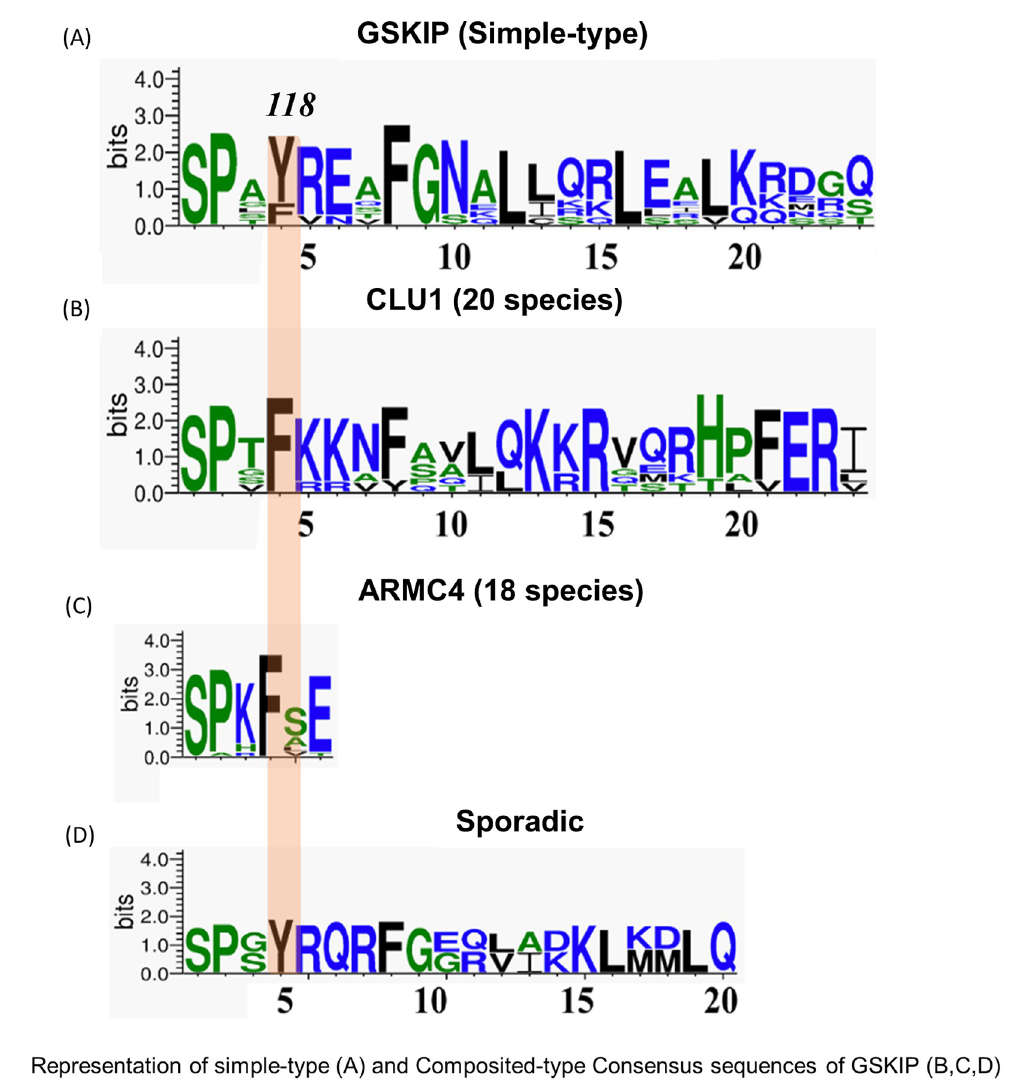
Fig 5. Differences in pre-GSK-binding site sequences. Four consensus GSKIP sequences were represented using Weblogo 3.6.0. A, GSKIP (simple-type). B, CLU1 (CLUH). C, ARMC4. D, Sporadic (Mitofilin and Hsp70/Dnak).